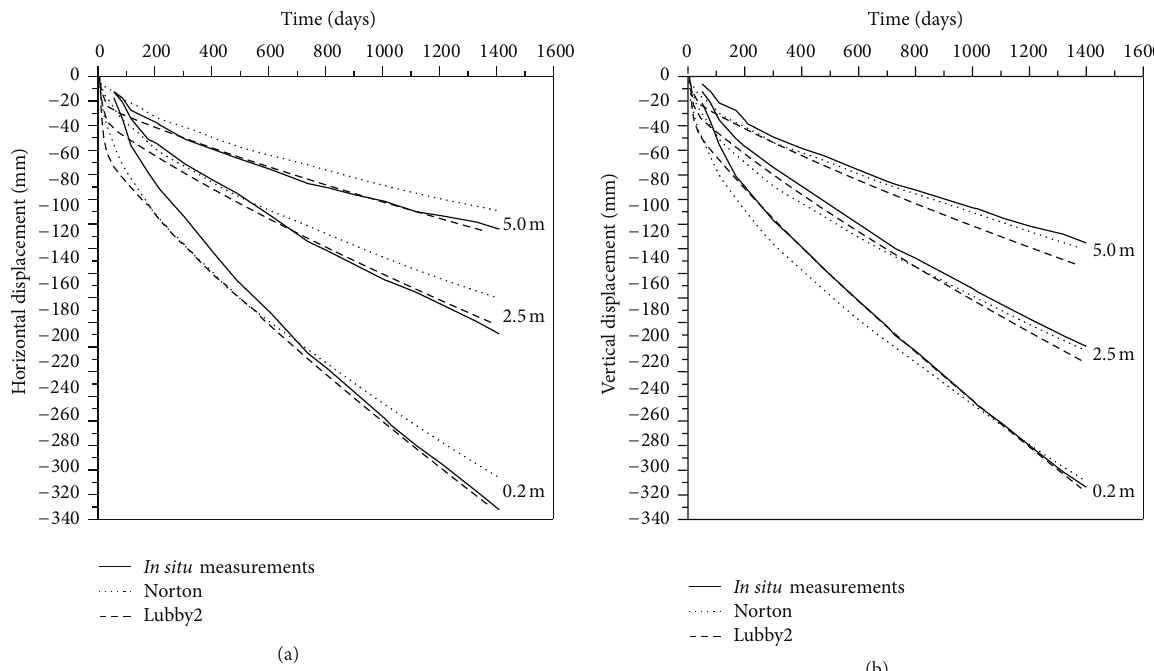
Figure 8: Validation of creep law parameters used in the study; changes of horizontal (a) and vertical (b) displacement versus time in the side wall of the gallery at a 1000m depth in the Polkowice-Sieroszowice copper ore mine